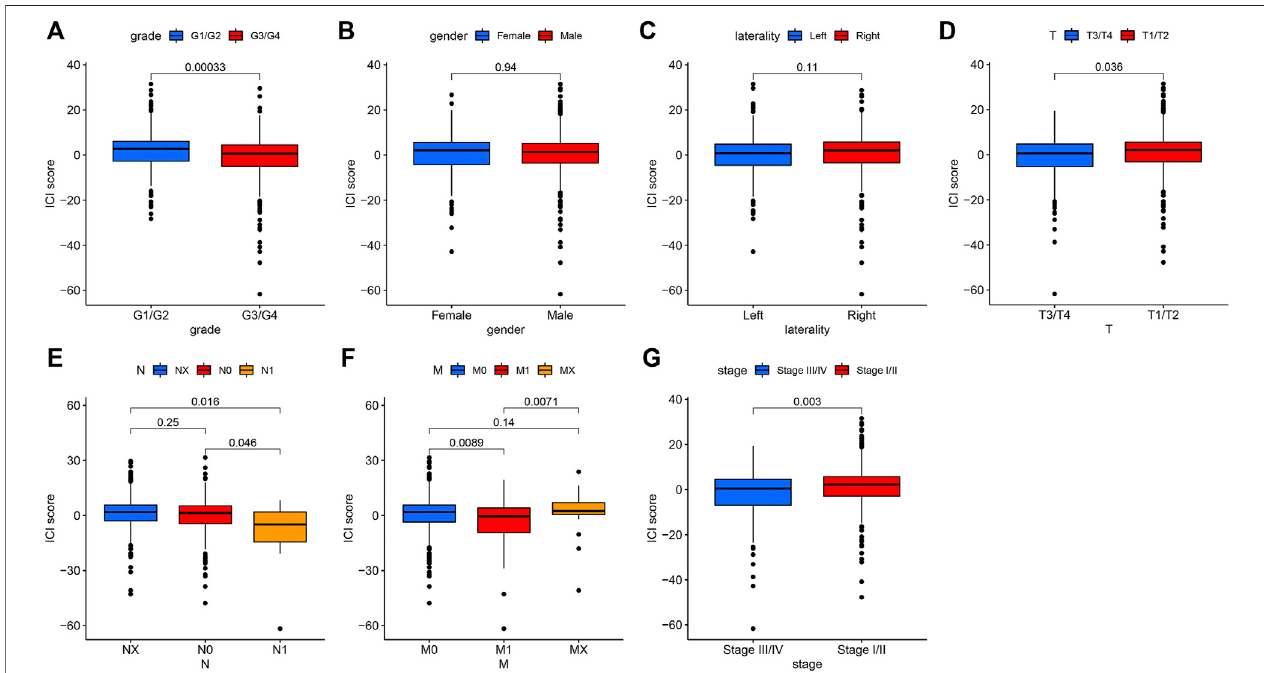
FIGURE 4 | The association between ICI scores and some clinical characteristics of patients with KIRC. (A) . The relationship between ICI score and Grade. p = 0.00033. (B) Gender parameter has no signi fi cant relationship with ICI score. (C) The association between laterality and ICI scores. (D) The patients with T3/T4 had low scores. p =0.036. (E) Thepositivenodemetastasis(N1)wassigni fi cantlyrelatedtolowICIscores. p =0.016. (F) Therelationshipbetweenmetastasis(M)withICIscores. p = 0.0089. (G) The low ICI score was observed in stages III/IV. p =